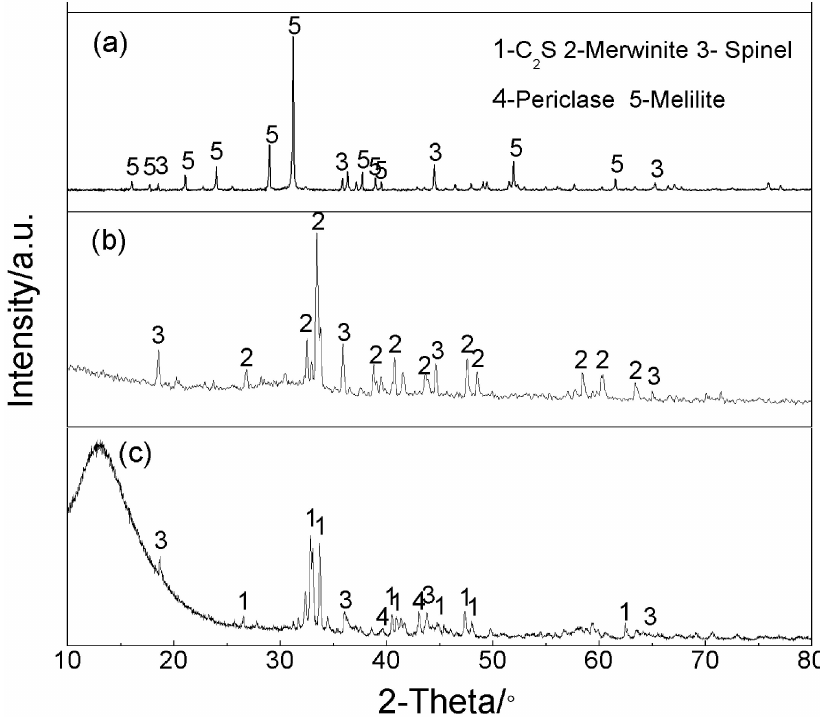
Figure 2. XRD patterns of S1, S2, and S3 quenched at 1300 ◦ C. ( a ) B = 1.0; ( b ) B = 1.5; ( c ) B =